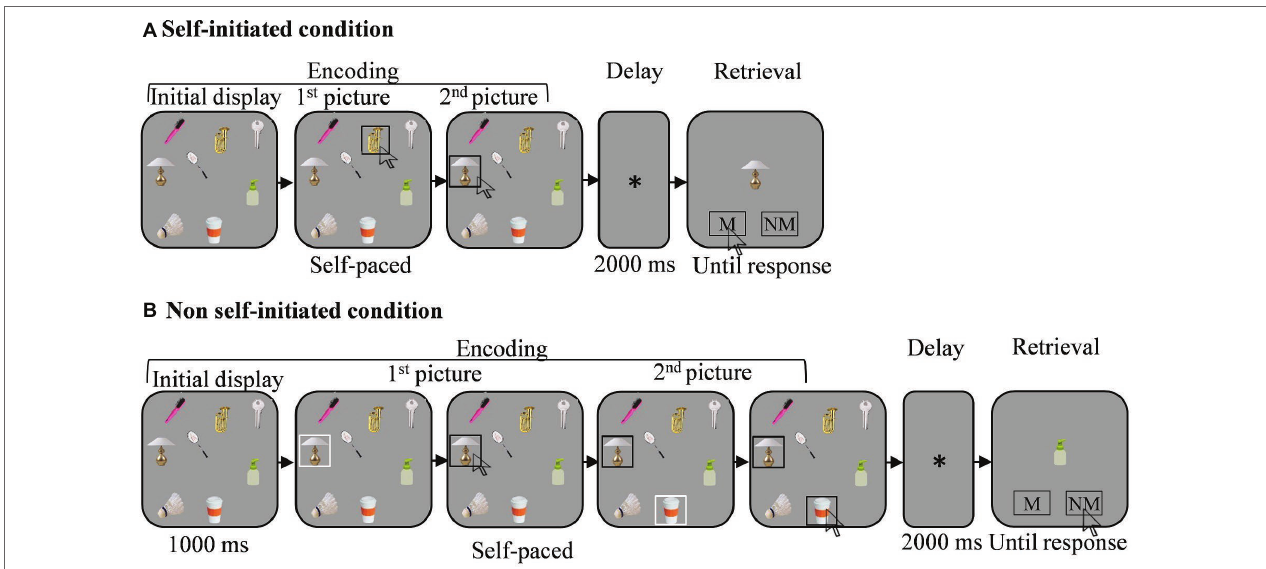
FIGURE 1 | Illustration of the memory task (see text for further detail). Each trial began with the presentation of an initial spatial array of 12 pictures (for presentation purposes only eight pictures appear in the figure. Note that the pictures are not to scale). In the self-initiated (SI) condition (A) participants clicked sequentially on the pictures they wished to memorize. In the non-SI condition (B) participants clicked in sequence on the pictures selected randomly by the computer, which were marked by a white frame. Encoding was self-paced in both encoding conditions. In both conditions, encoding was followed by a short delay of 2,000 ms, after which a single probe appeared in the screen center, and either matched or did not match one of the selected pictures. Participants responded by clicking on one of the response areas that appeared with the probe. M, match. NM,